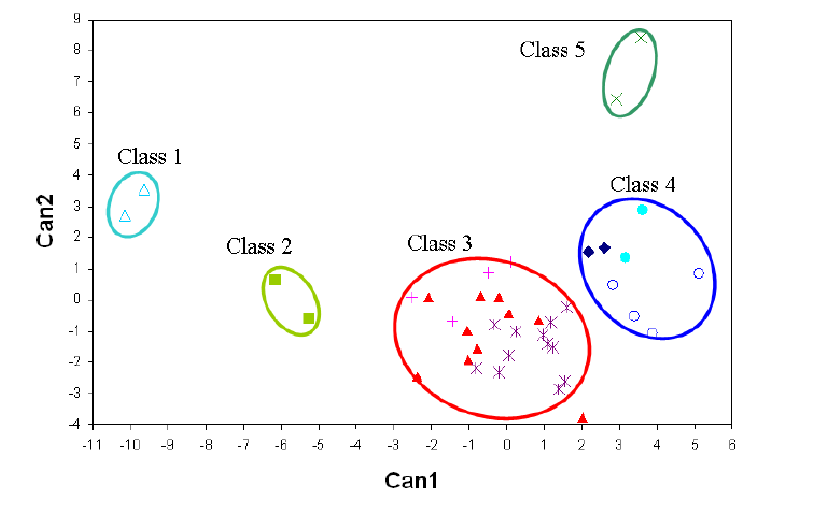
Figure 4. Score plot of the first two canonical variables of the linear discriminate analysis based on the intensity of mass to charge ratio of 34 wines. The symbols represent the six geographical origins of Sauvignon Blanc wines samples. Loire ( ♦ ), Marlborough ( ▲ ), South Australia ( ∆ ), Tasmania ( ● ), Victoria (+ ) , Western Australia ( ○ ) (reprinted from [80] with permission from Elsevier, copyright